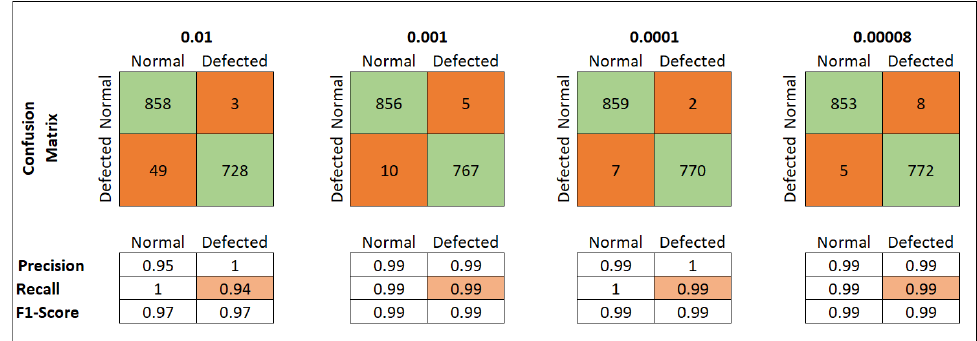
Figure 17. Classification report of model3 on different learning